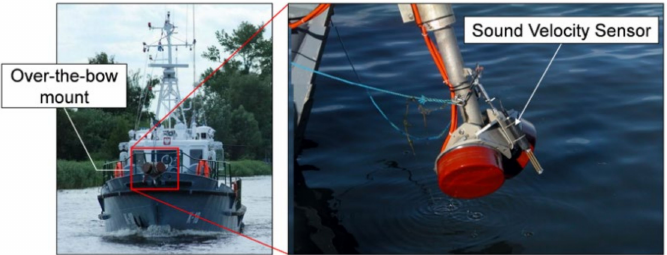
Figure 9. Polish Navy hydrographic cutter equipped with Kongsberg Maritime EM3002D multibeam echosounder mounted over-the-bow. Sound velocity sensor is mounted at the end of the pole, between